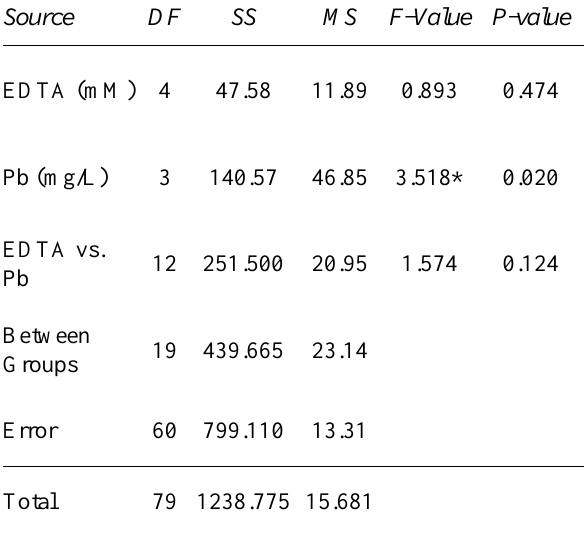
Table 2: Effects of Pb and EDTA concentrations on total chlorophyll (µg/mg dry weight of leaf) of I. lacunosa L.; two-way ANOVA with replication.